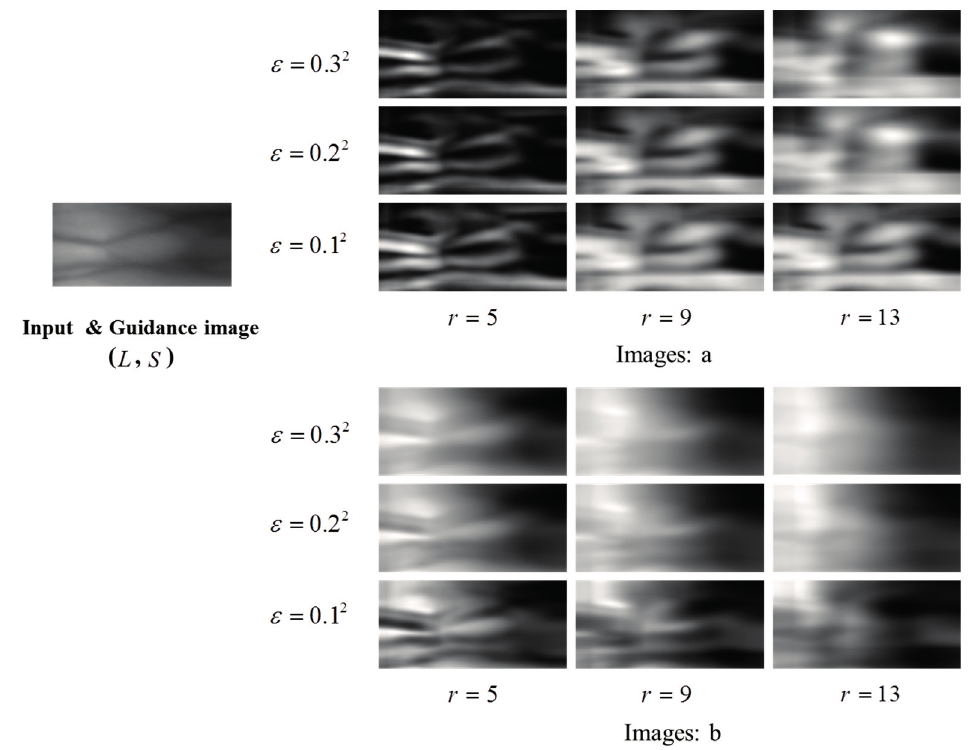
Figure 4. Examples of parameters ( , ) a b of the guided filter according to different parameters ( , ) r ε